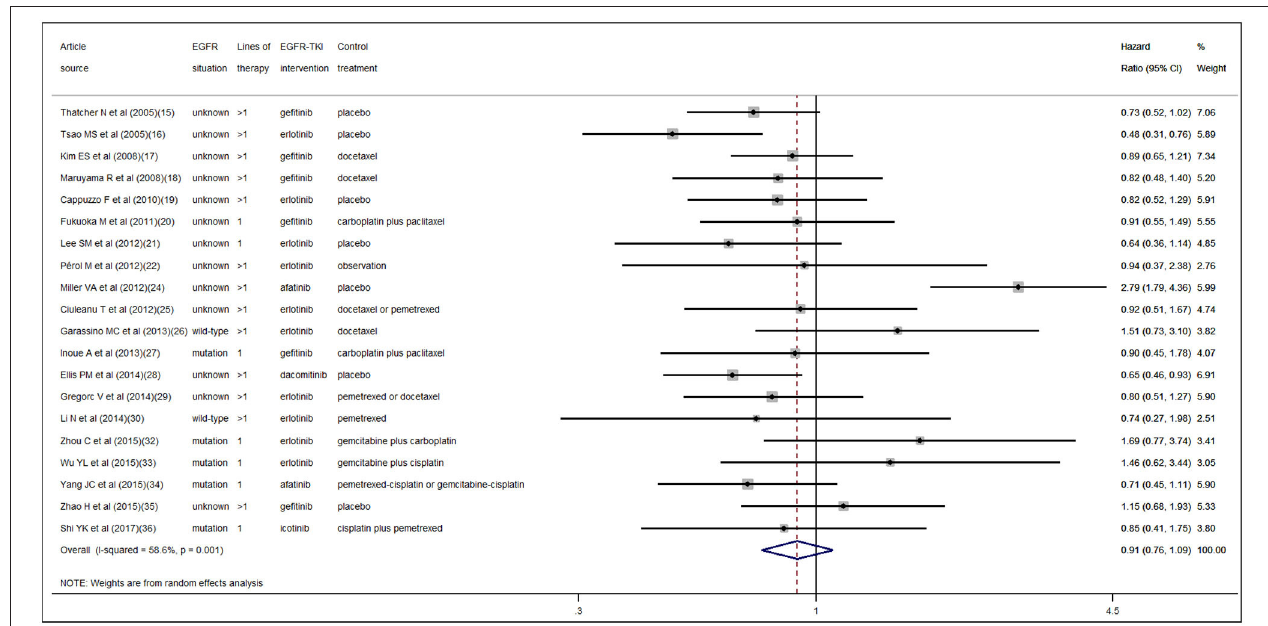
FIGURE 3 | Forest plot of the pooled analysis of the interaction hazard ratios of smoking status.